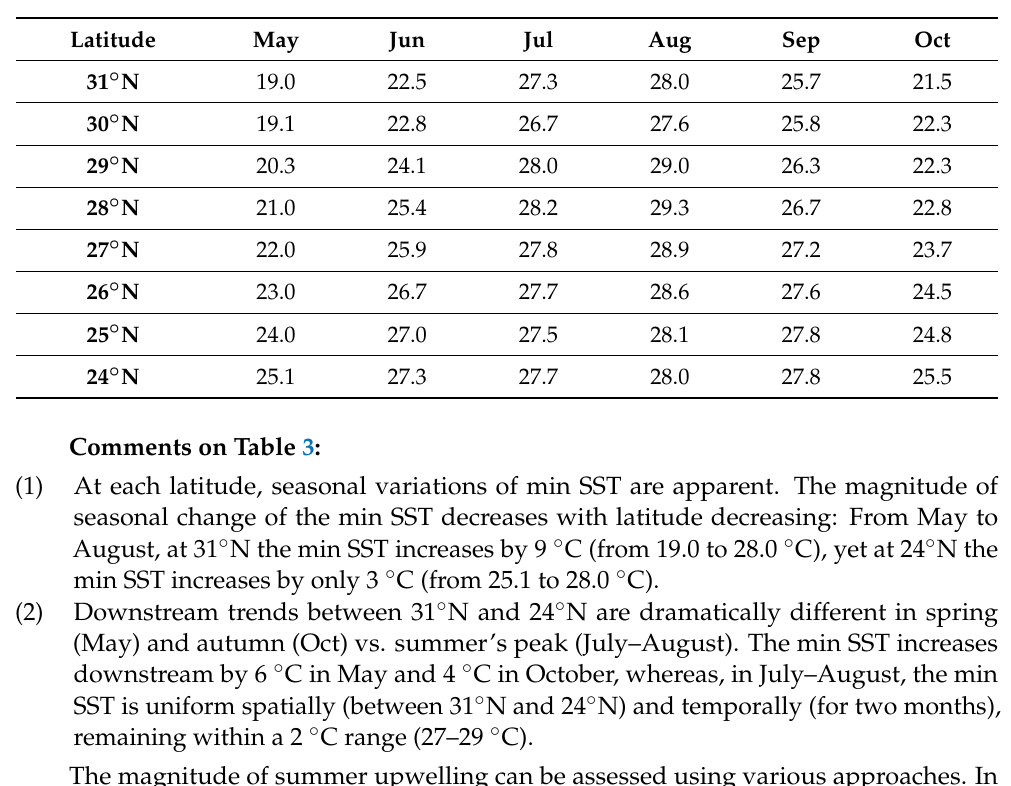
Table 3. Minimum SST ( ◦ C) during warm